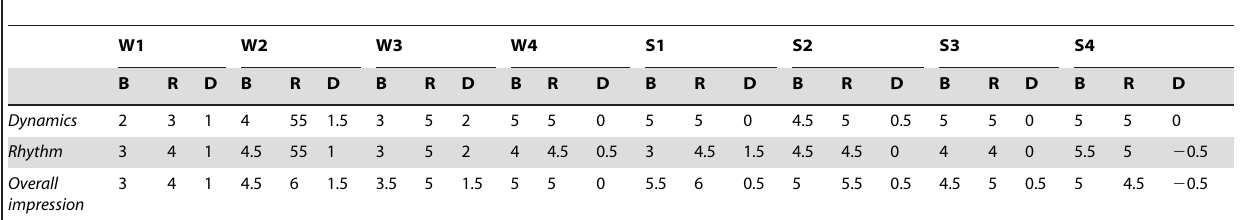
Table 4. Video assessment of the rower’s general development (D) from baseline (B) to retention (R).